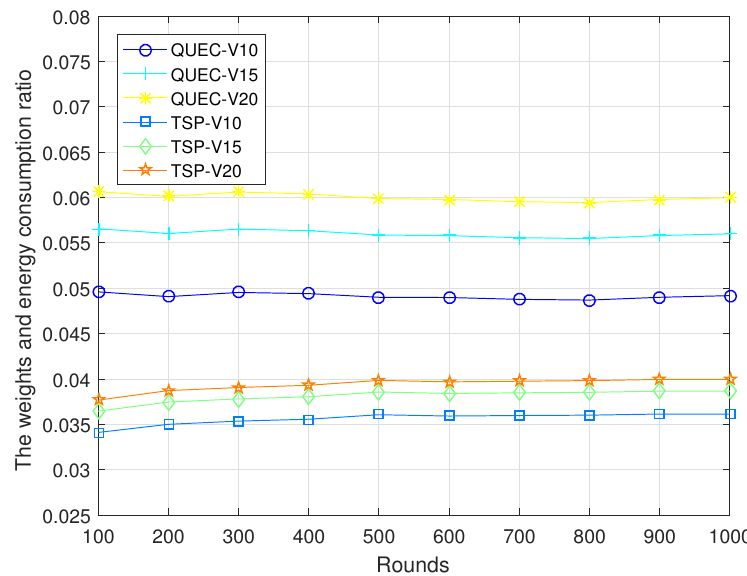
Figure 8. The weights and energy consumption ratio.